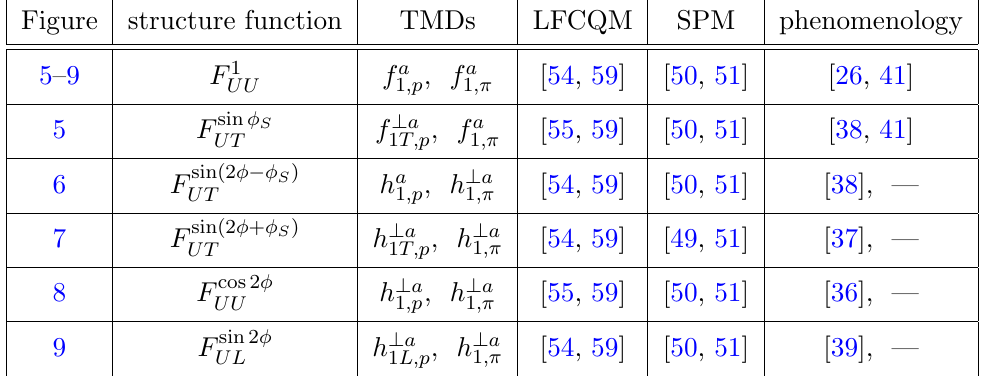
x p Figure 9 . A sin2 (cid:30) as a function of x p (left), x (cid:25) (middle) and q T (right) in the COMPASS UL kinematics. Figure structure function TMDs